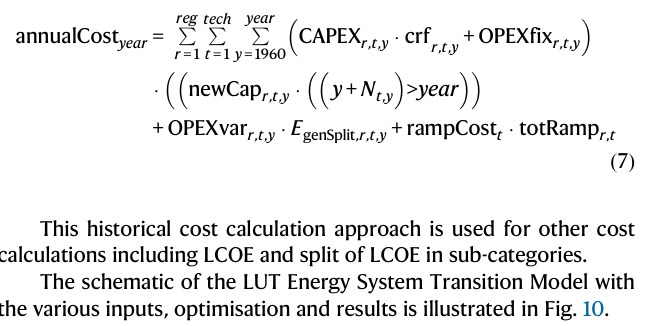
Fig. 10 | Schematics of the LUT Energy System Transition model. The model consists of various primary data as an input to the optimisation process, where,